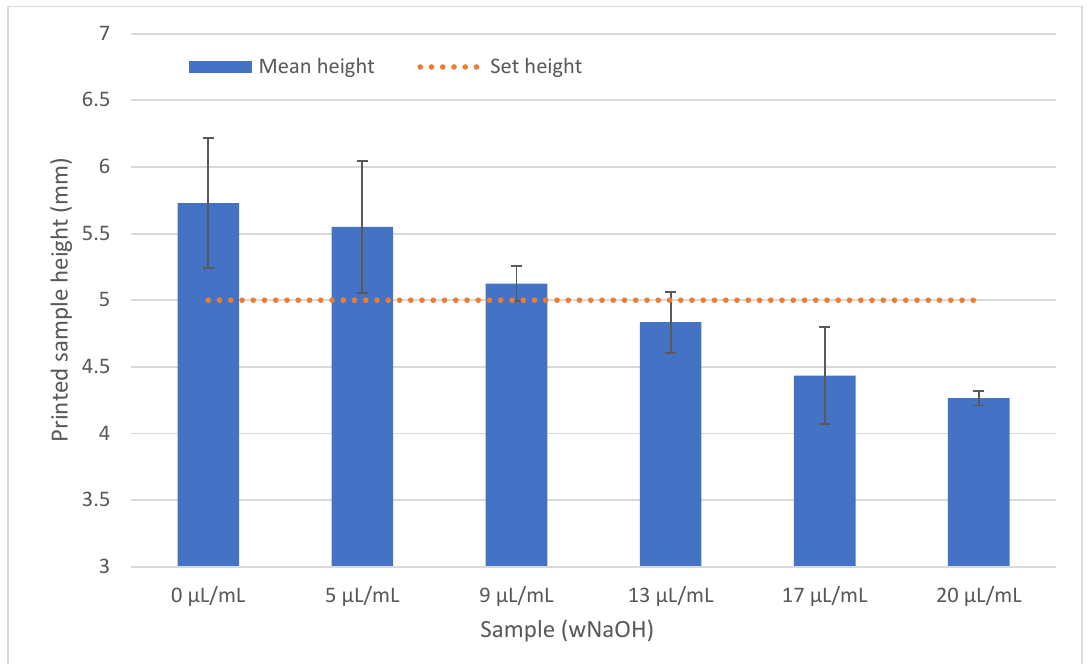
Figure 6. The height of the samples, depending on NaOH concentration, was negatively correlated to their diameter. The bars represent the mean value with SD; N = 4.